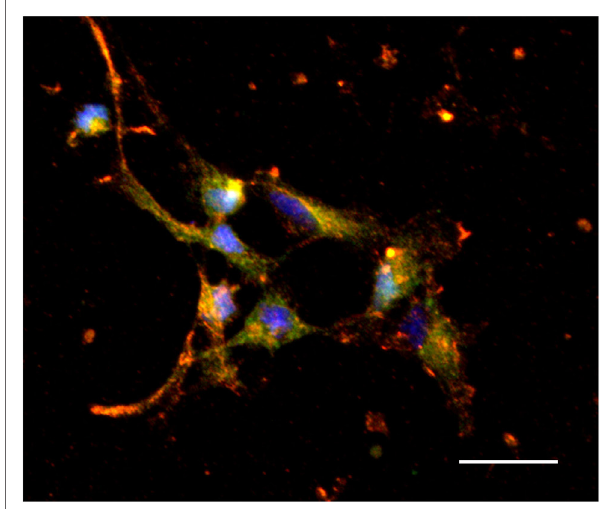
FiGURe 3 | Colocalization of CCR2 and enkephalin in hypothalamic neurons . Hypothalamic neurons extracted from chow-exposed embryos showing CCR2 to colocalize with the orexigenic peptide, enkephalin (orange). Scale: 25 μ m. Green: enkephalin, red: CCR2, and blue: dapi.